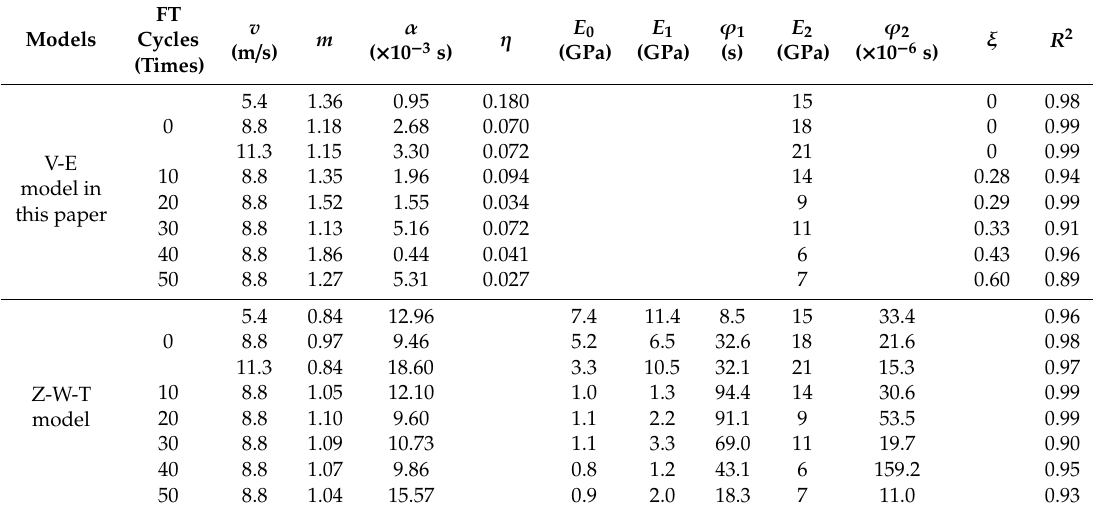
15 of 18 Figure 13. Comparison results of constitutive model curves under impact velocity of 8.8 m/s. ( a ) FT0; ( b ) FT10; ( c ) FT20; ( d ) FT30; ( e ) FT40; ( f ) FT50. Table 2. Parameter inversion results of different constitutive models.